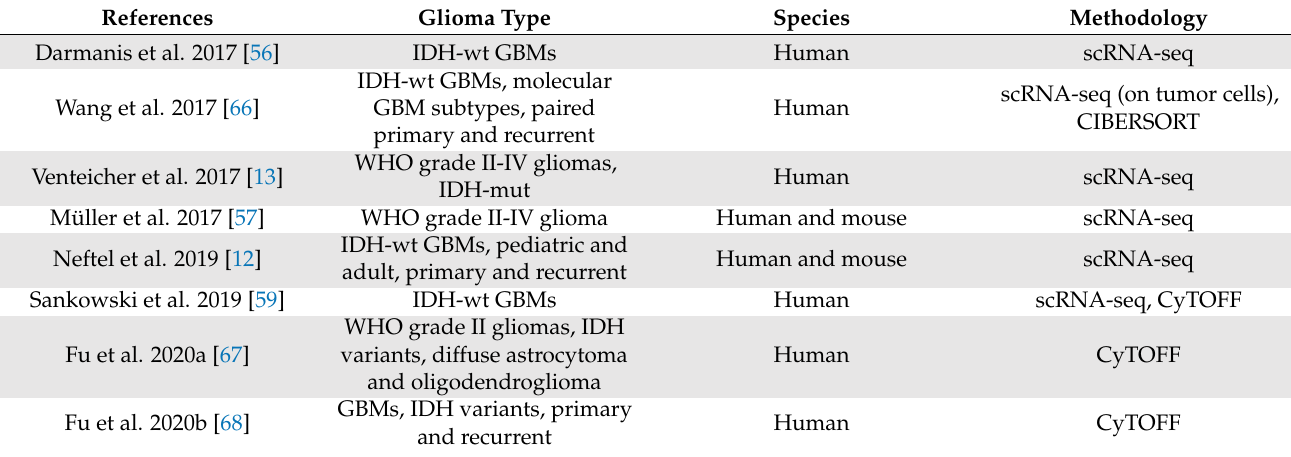
Table 1. List of the reviewed scRNA-seq and CyTOF publications on human malignant